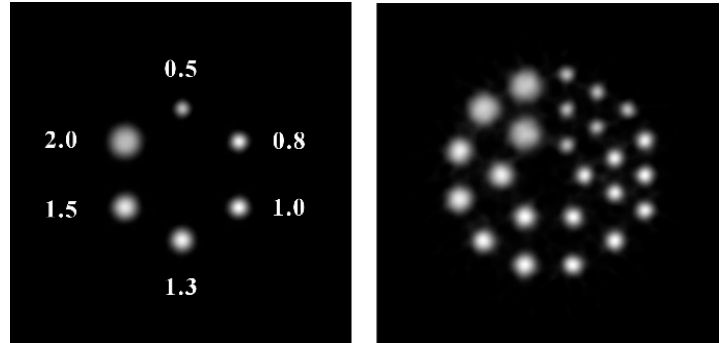
Figure 6. Reconstructed PET images of a rod source phantom and a Derenzo phantom for the IS coincidence events. The diameters of the sources from small to large were 0.5, 0.8, 1.0, 1.3, 1.5, and 2.0 mm.